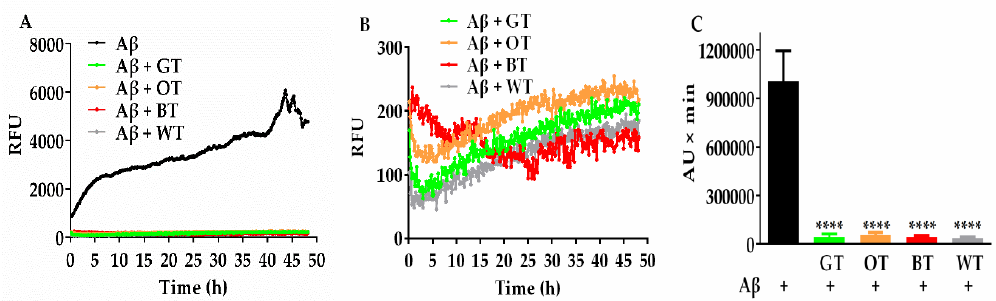
Figure 4. ( A ) Thioflavin T Kinetic (ThT) fluorescence representing kinetics of A β (10 µ M) fibrillization over 48 h, alone or in the presence of each tea extract (100 µ g / mL). ( B ) ThT fluorescence representing kinetics of A β (10 µ M) fibrillization over 48 h, in the presence of each tea extract (100 µ g / mL). ( C ) Respective area under (AU) the curve measurements per minute demonstrating significant reductions in ThT fluorescence output for WT, GT, OT and BT. **** p < 0.0001. Results were expressed as mean ± standard deviation ( n = 4).